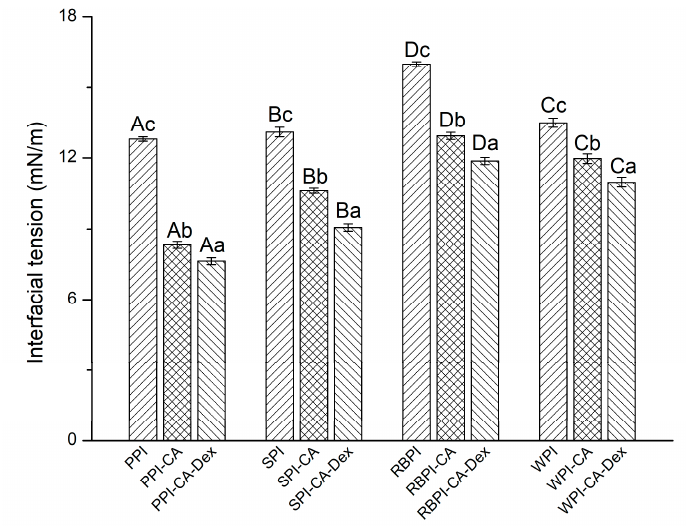
Figure 3. The interfacial tensions of NP, PC, and PCD samples. A–D represented that there were statistically differences ( p < 0.05) in interfacial tensions among nanoemulsions stabilized by four NPs, four PCs, or four PCDS, a–c represented that there were statistically differences ( p < 0.05) among NP, PC, and PCD in same proteins.